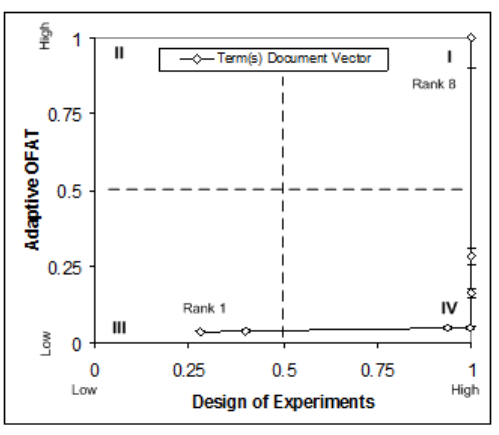
Figure 6. Toyota’s thinking for testing information